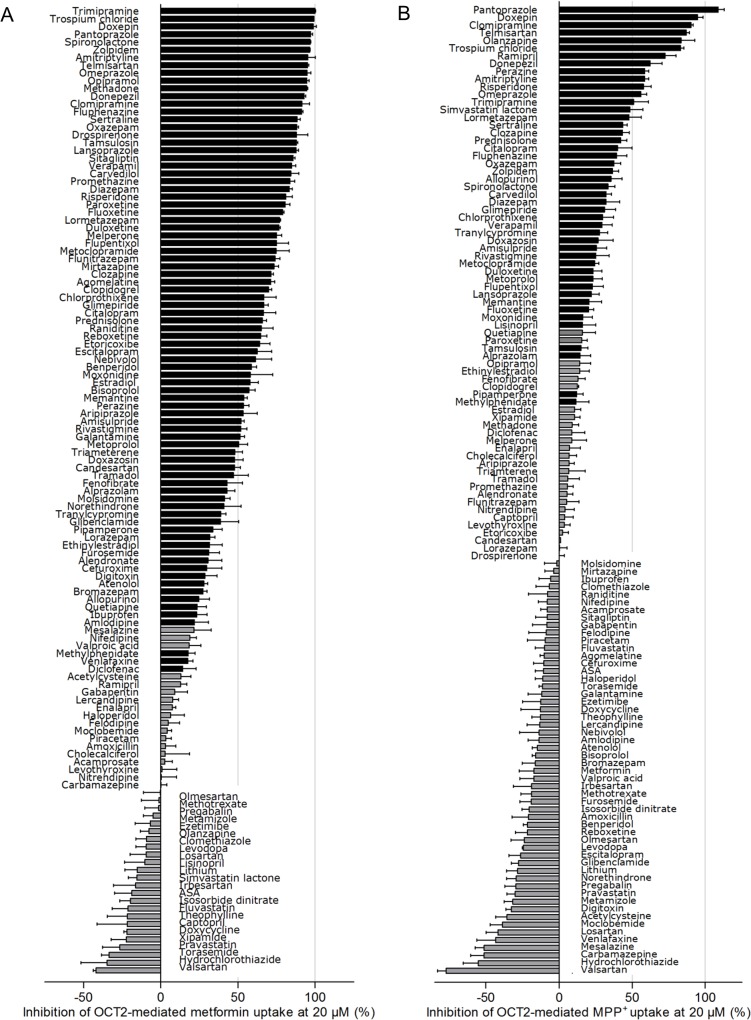
Inhibitors of OCT2-mediated metformin (1000 μM) and MPP+ (50 μM) transport identified in a screen of 125 drugs most commonly prescribed in Germany.(A) Inhibition of metformin transport. (B) Inhibition of MPP+ transport. Each bar represents one compound tested in HEK-OCT2 cells at a concentration of 20 μM. Bars showing a statistically significant (one-sample t test) inhibition are shaded in black. Data are presented as the mean +/- standard error (at least two experiments each on two or more separate days, i.e., n = 4–15). Negative inhibition values indicate enhanced OCT2-dependent substrate uptake in cells incubated with the respective test drug compared with vehicle-treated cells; ASS, acetylsalicylic acid.